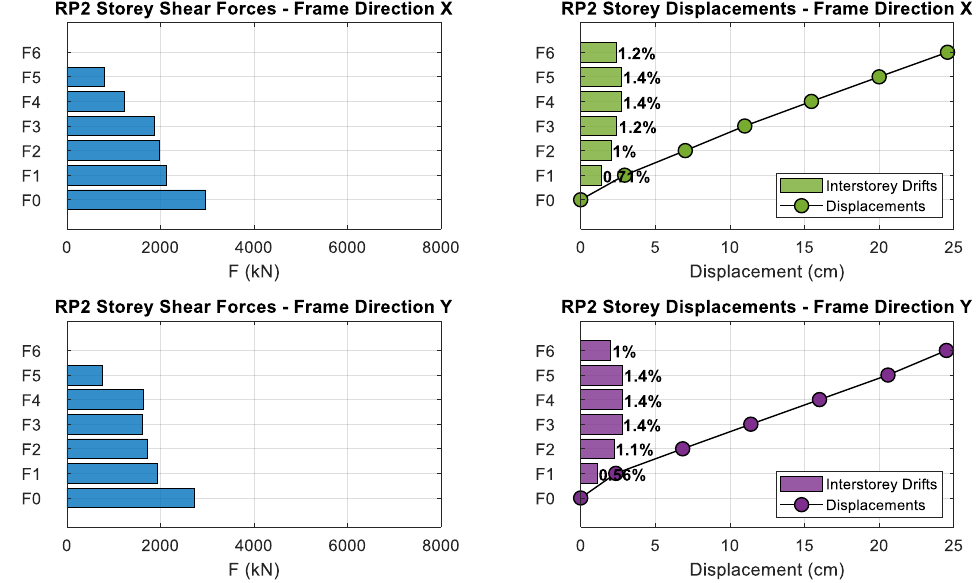
Figure 15. RP2 storey shear forces and displacements.